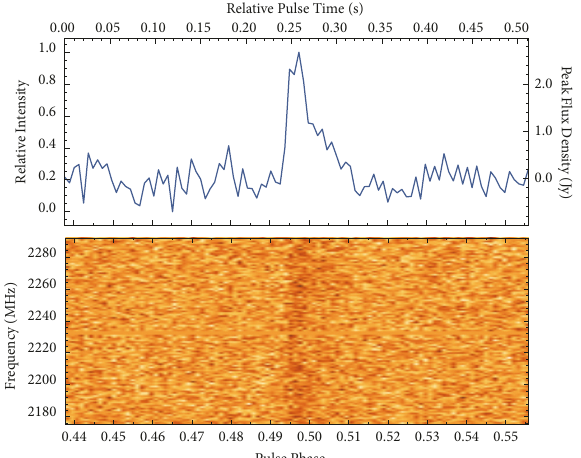
Figure 8: Example of a bright single pulse detected at 𝑆 -band from PSR J1622–4950 during the observation on 2018 May 10 (see Figure 7(b)). In the top panel, we show the integrated single pulse profile with a time resolution of ∼ 5 ms. The dynamic spectrum, dedispersed at the magnetar's nominal DM of 820 pc cm −3 , is shown in the bottom panel. This event has a S/N of ∼ 10 and was detected by convolving the dedispersed time-series with a ∼ 23 ms wide boxcar template. The shape of the single pulse is noticeably